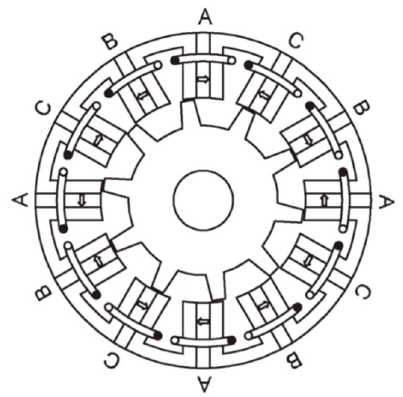
Figure 11. Configuration of a flux-switching PM (FSPM) machine [33].